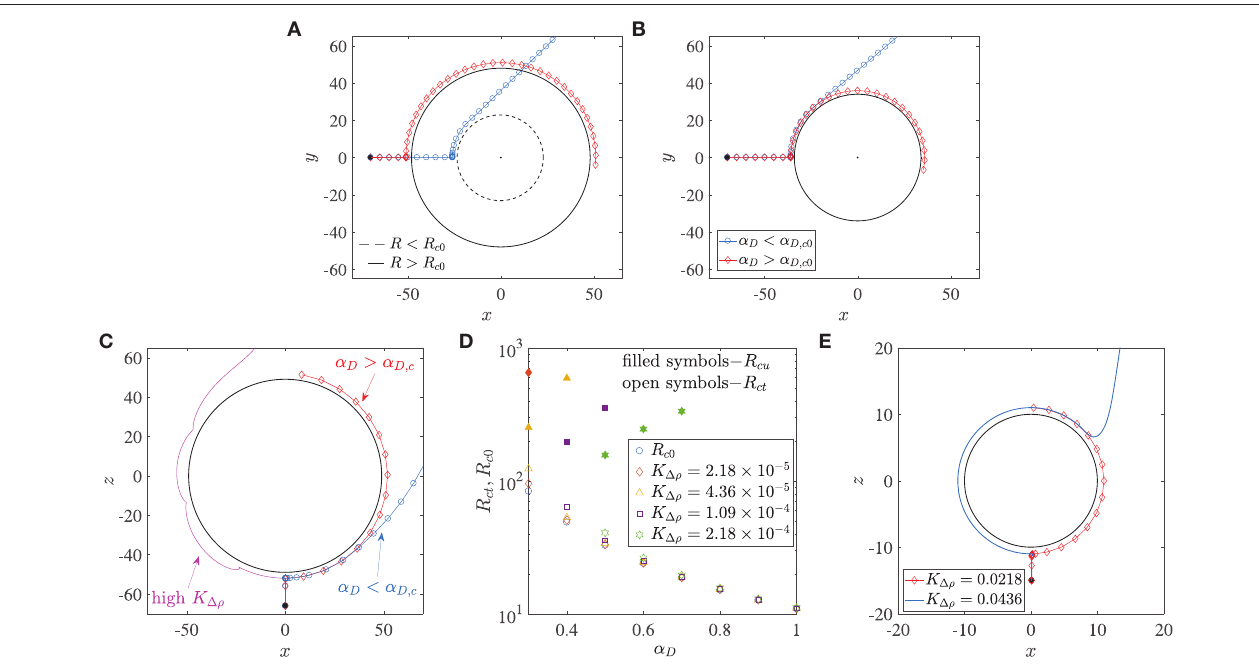
FIGURE 3 | (A) The critical trapping radius for a stationary sphere: a bacterium gets trapped (resp. escapes) if the radius of the sphere being encountered is larger (resp. smaller) than a critical value. (B) Bacterium with dipole strength larger (resp. smaller) than the critical dipole strength, α D , c 0 is trapped (resp. escapes) around a sphere of given radius R . (C) Trapping around a settling sphere: the trajectories are plotted in the frame of reference moving with the sphere and gravity acts along the − z direction; α D , c is the critical dipole strength above which hydrodynamic trapping occurs (for a settling sphere). (D) Open symbols show the variation of the critical trapping radius of a sphere settling under gravity, R ct , with the bacterium’s dipole strength, for different values of dimensionless excess density K 1ρ . R c 0 is the value of the critical trapping radius for a stationary sphere. Note that the external force acting on the particle is a function of its radius. The shape of the symbols corresponds to the K 1ρ values given in the legend. Filled symbols denote the values of the upper limit of aggregate radii R cu , above which the faster settling of the aggregate dominates the hydrodynamic attraction effect and thus prevents bacterium capture. These values of R cu exist only for the cases shown; in all other situations, the aggregate Reynolds number becomes O (1) (wherein our theory becomes inapplicable) before such “rapid-settling induced escape” is seen. (E) An illustration of the fact that hydrodynamic capture fails to occur if the dimensionless excess density K 1ρ exceeds 4 × 10 − 2 . The dimensionless bacterial dipole strength used in the simulation is α D = 2, which is the maximum value used in this paper; and the dimensionless radius is R = 10, which is the minimum value considered across all our analyses. Note that trajectories for K 1ρ < 0.0218 are not shown to improve clarity, as they all overlap over the one marked by